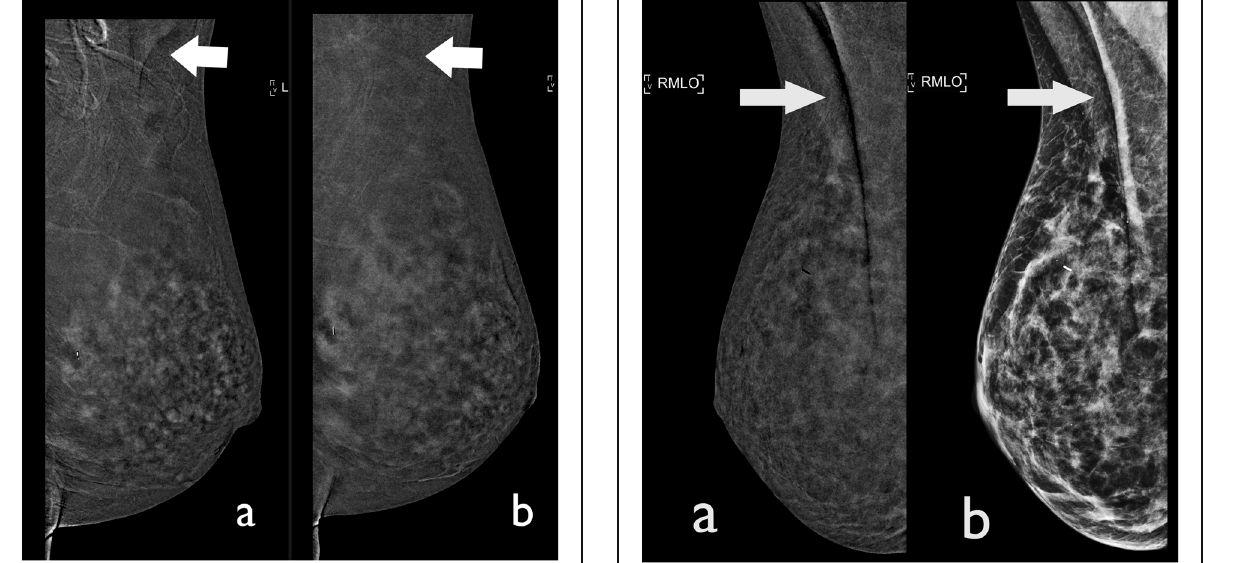
Fig. 4 Air trapping artefacts: A CEDM performed for problem solving